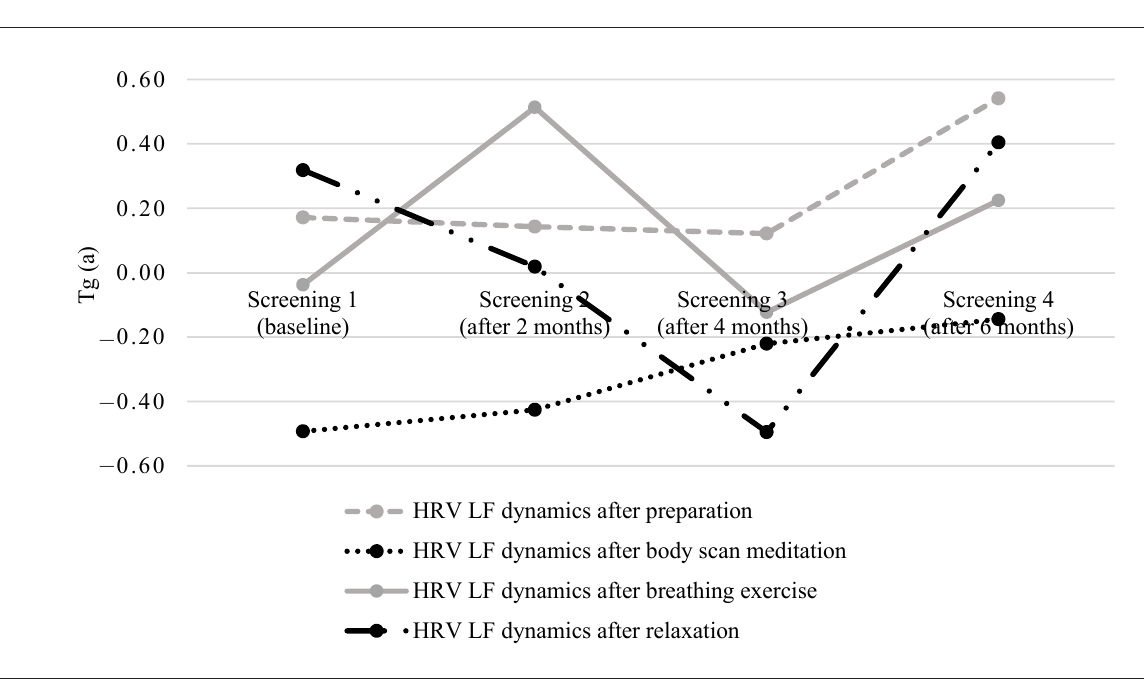
Figure 4. HRV LF dynamics during 6-month period